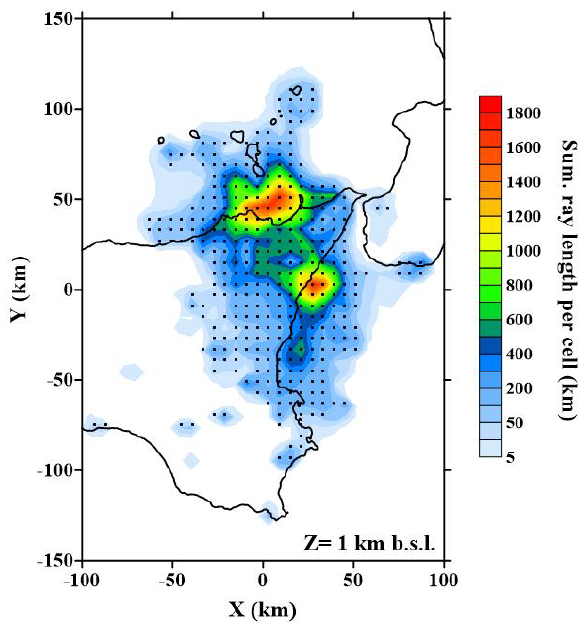
Figure 6. Example of the ray density and node distribution calcu- lation for the TOMO-ETNA